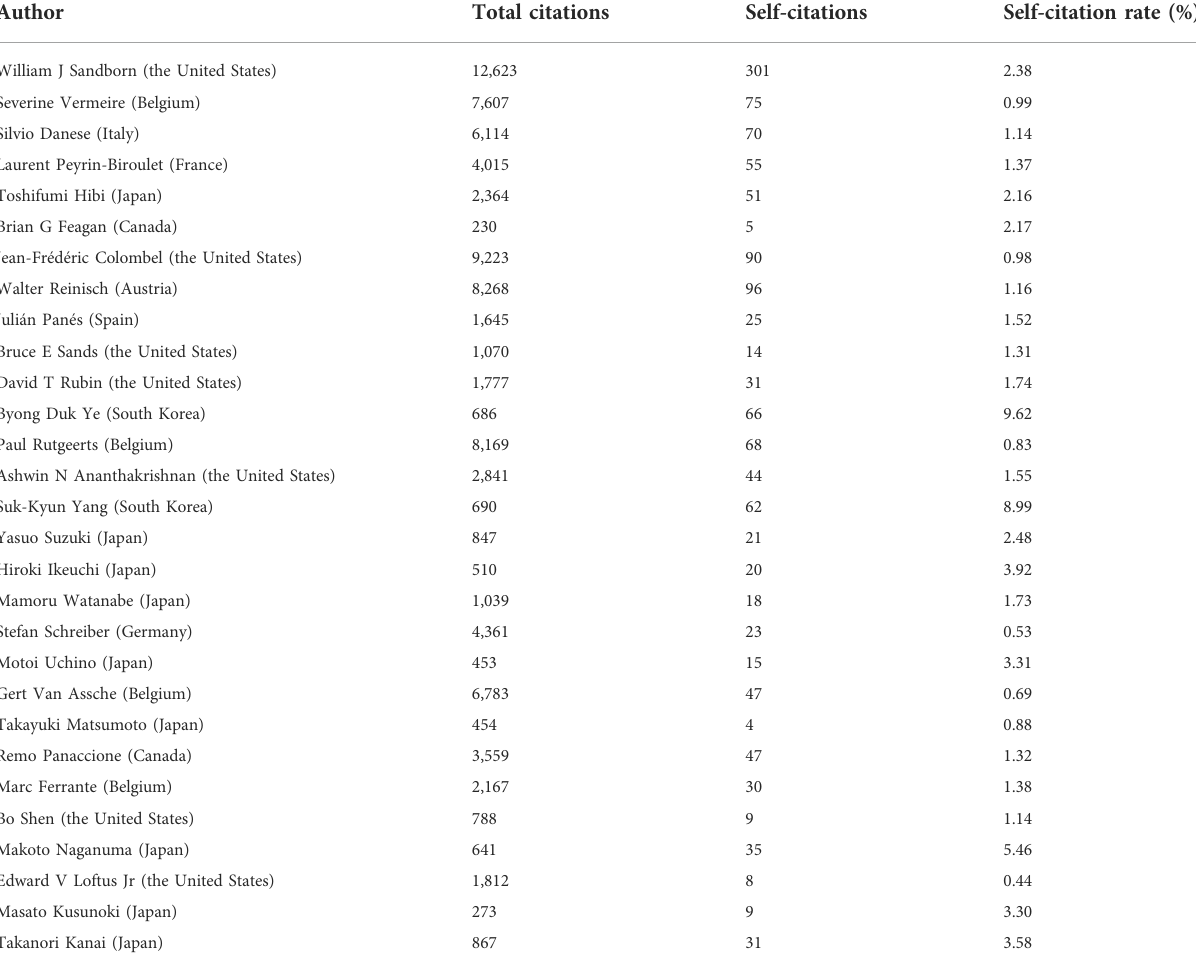
TABLE 4 Self-citations of the top productive authors involved in UC